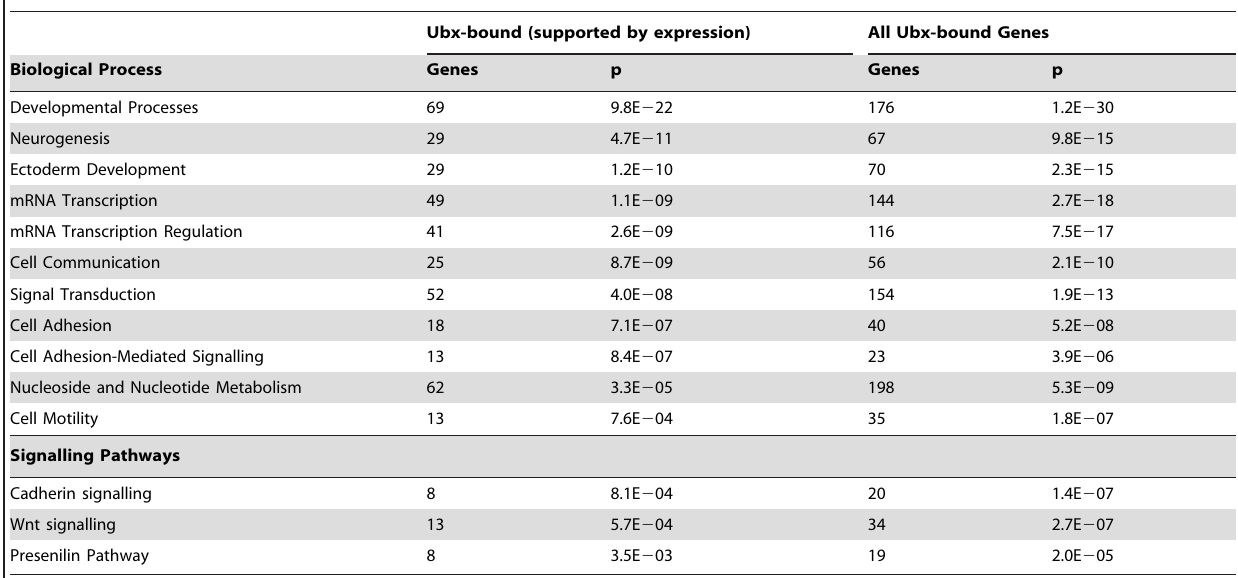
Table 1. Gene ontology and other function enrichments associated with Ubx-bound genes that have identified expression changes or the complete set bound by Ubx at 1%